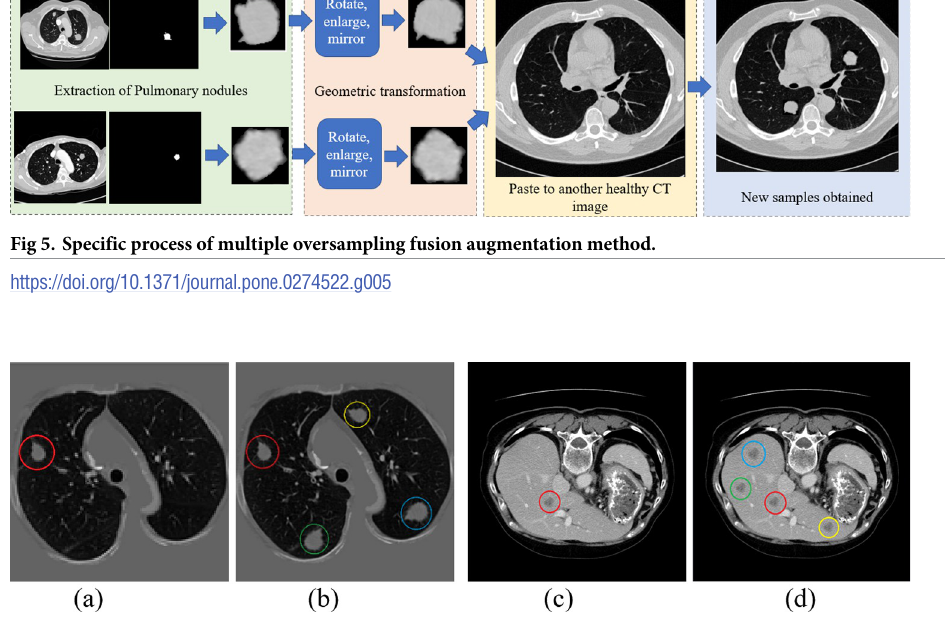
Fig 6. Samples of multiple oversampling fusion augmentation method. (a) original image of pulmonary nodule image, (b) is the result of (a) using fusion oversampling, (c) original image of liver tumor image, and (d) is the result of (c) using fusion oversampling. (a red circle represents the original lesion area, a yellow circle represents mirrored and rotated lesion area, a blue circle represents magnified and rotated lesion area, and a green circle represents magnified and mirrored lesion